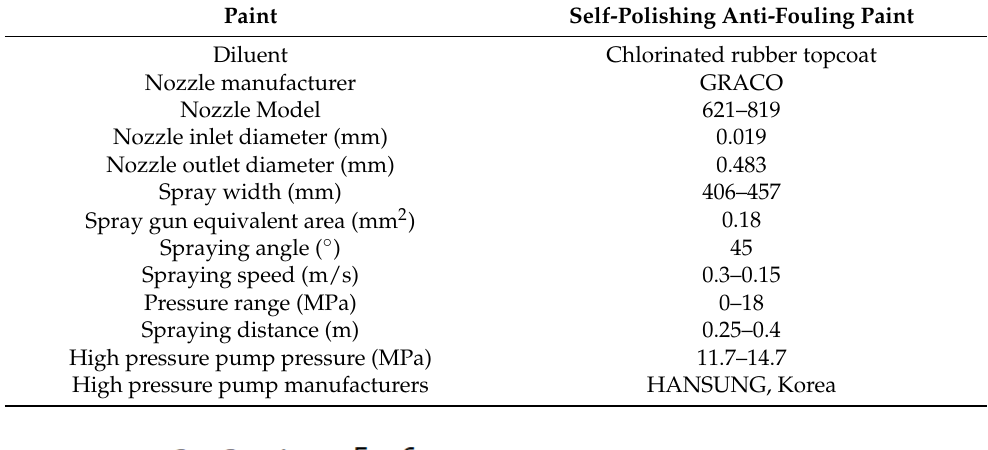
Figure 3. Current status of hull painting work in a shipyard in Dalian.